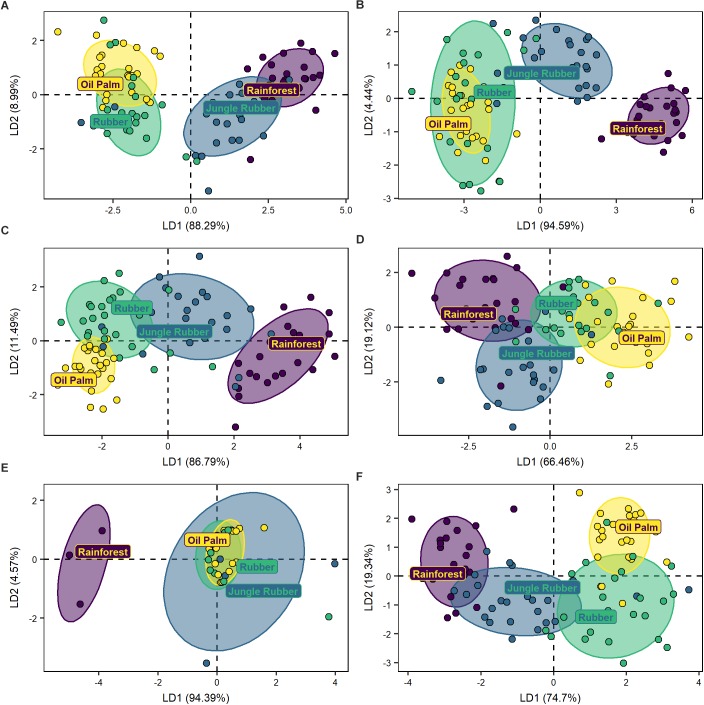
Discriminant function analyses of five trophic groups of protists (A) phagotrophs, (B) animal parasites, (C) photoautotrophs, (D) plant parasites, (E) symbionts, and of undetermined protists (F) from four land-use systems (rainforest, jungle rubber, rubber plantation, and oil palm plantation). Ellipses drawn for visualization of the respective land-use systems include 75% of the respective plots.